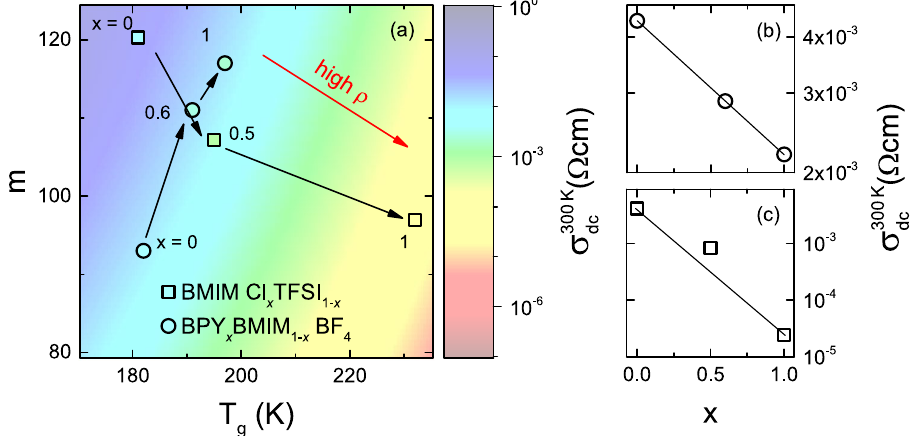
Figure 4. Fragility, glass-transition temperature and room-temperature conductivity of the mixed ionic liquids. Fragility and T g are given in ( a ) for BPY x BMIM 1 − x BF 4 and BMIM Cl x TFSI 1 − x , as derived from the temperature dependence of the ionic dynamics. Black arrows indicate variations of x . The color-coded background ( a ) represents conductivity as a correlation of m and T g , according to ref. 26. The symbols’ color represent the measured conductivity of the samples at room temperature. Additionally room-temperature conductivity vs . the mole fraction x is shown for BPY x BMIM 1 − x BF 4 ( b ) and BMIM Cl x TFSI 1 − x ( c